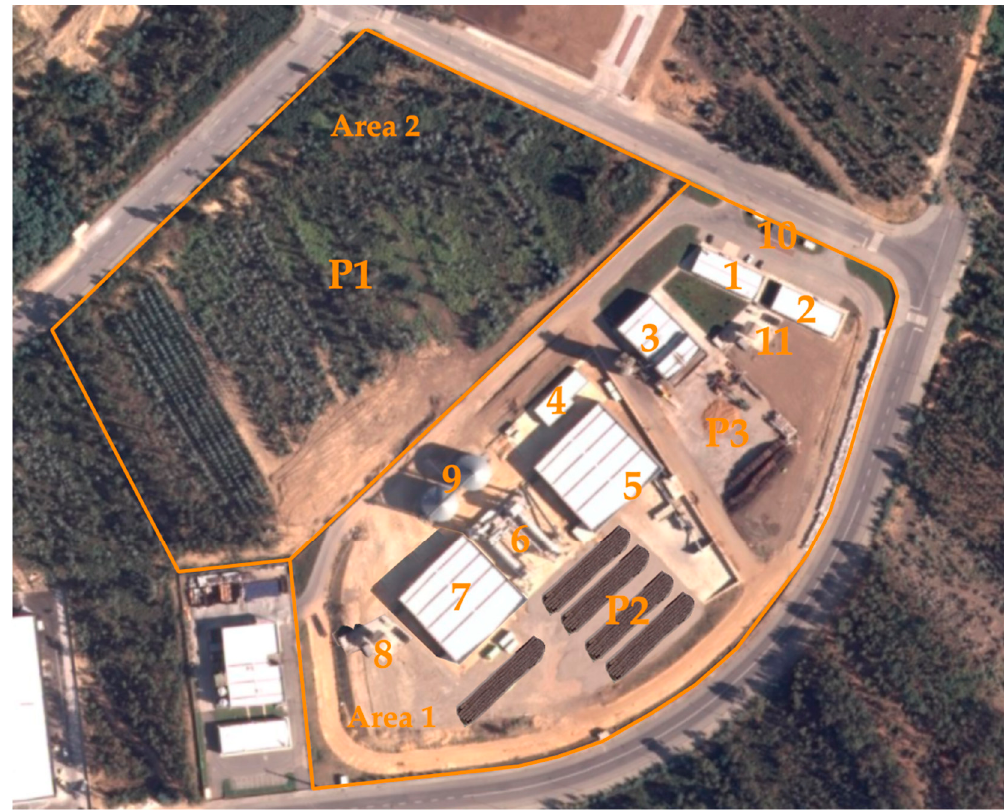
Figure 1. Advanced Fuel Solutions SA (AFS) facilities, where Area 1 corresponds to a plot of land of 42,000 m 2 and Area 2 corresponds to a plot of land of 40,000 m 2 . P1 corresponds to a 2500-m 2 raw material storage park that supports the experimental pilot unit; P2 corresponds to a raw material storage park of approximately 7500 m 2 that serves for the production support stock; and P3 corresponds to a 40,000 m 2 storage park that serves as a strategic storage stock, with a capacity for 3 months of production. (1) Social building; (2) R&D department; (3) pilot-industrial scale production unit; (4) maintenance building and parts warehouse; (5) raw material pre-processing section; (6) biomass drying and torrefaction unit; (7) densification section; (8) armed fire network of the industrial scale production unit; (9) finished product silos; (10) ordinance and scale; and (11) armed fire network of the pilot-industrial scale production unit.